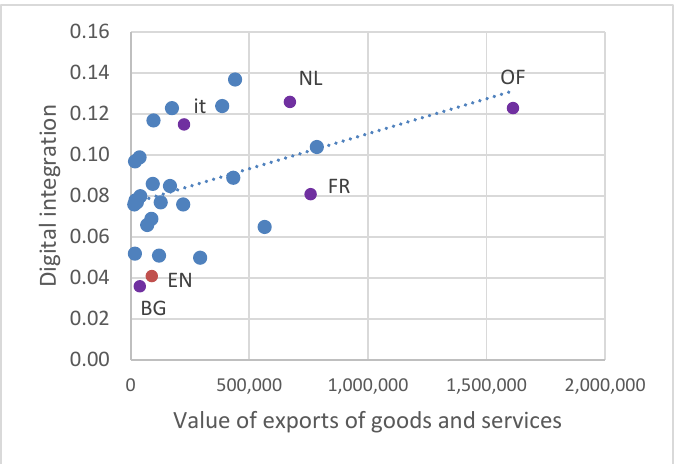
Figure 7. The relationship between digital integration and exports was added to the EU in 2019.